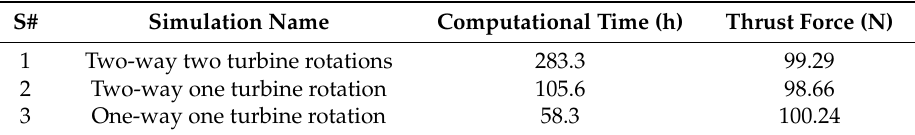
Table 1. Comparison of the computational time and thrust force prediction.